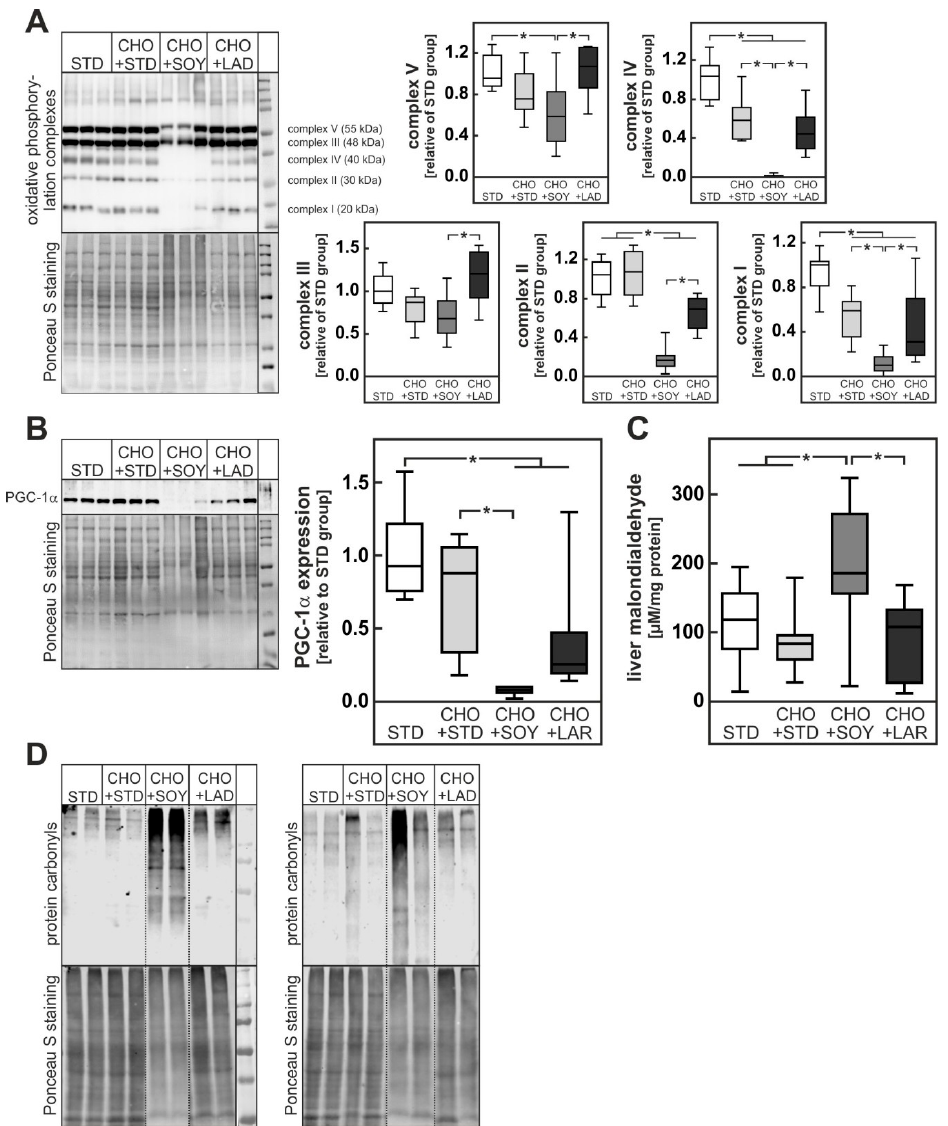
Figure 6. Increased mitochondrial damage and oxidative stress in mice fed a CHO + SOY diet for 20 weeks. ( A , B ) Hepatic protein expression of the oxidative phosphorylation complexes ( A ) and PGC-1 α ( B ). Dense intensity was normalized to Ponceau S staining, which was verified on the same Western blot membrane as a loading control and calculated relative to the STD group in each gel. A representative blot is shown. All original blots are provided in the Supplementary Material, Figures S1 and S2. ( C ) Concentration of malondialdehyde in liver as a marker of lipid peroxidation. ( D ) Determination of protein carbonyls in liver homogenates verified by oxyblot with Ponceau staining as a loading control. Blots were cut at the dotted lines. Original blots are shown in the Supplementary Material, Figures S3. Values are median (line), upper- and lower quartile (box) and extremes (whiskers) of 8–10 ( A , B ) or 9–28 ( C ) mice per group. Statistics: One-way-ANOVA with Tukey’s post hoc test for multiple comparisons. *: p < 0.05.